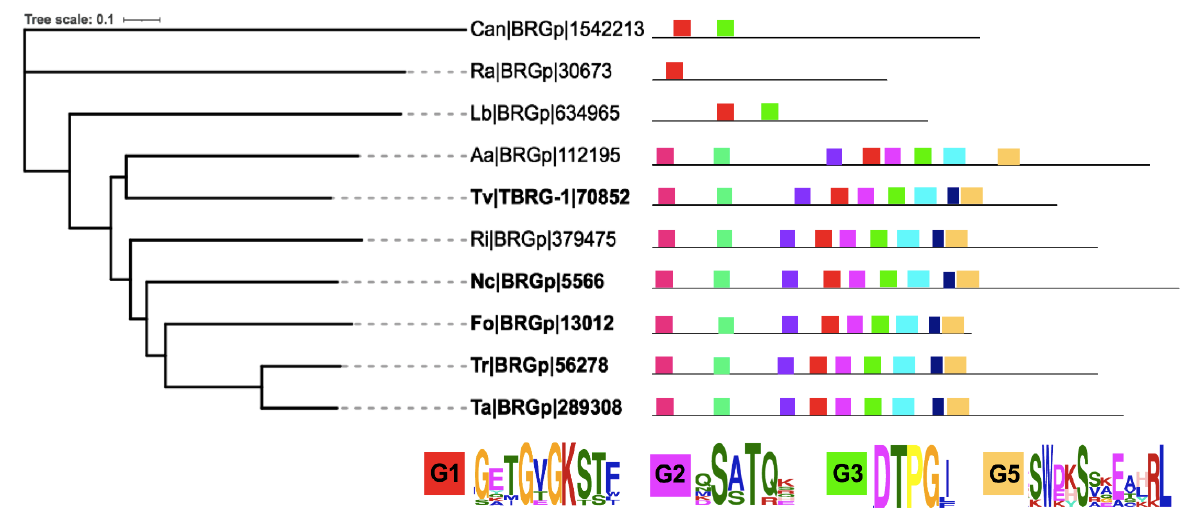
Figure 6. The BRG family is mainly present in Sordariomycetes. The evolutionary history was inferred using the neighbor-joining method [27] using the 10 putative BRG proteins from Cryptomycota, Blastocladiomycota, Mucoromycota, Basidiomycota, and Ascomycota phyla. The bootstrap test was applied using 1500 replicates [28]. The tree is drawn to scale, with branch lengths in the same units as those of the evolutionary distances used to infer the phylogenetic tree. The evolutionary distances were computed using the Poisson correction method. Evolutionary analyses were conducted in MEGA7 [29]. The motifs’ locations according to MEME results are indicated to the right of the tree, where each colored box represents a motif or conserved region. The consensus sequences obtained from the MEME-suite [35] of each motif found are shown together with each corresponding colored box. The height of each amino acid corresponds to its frequency of occurrence in the alignment. Those strains belonging to Sordariomycetes are indicated with a bold letter.